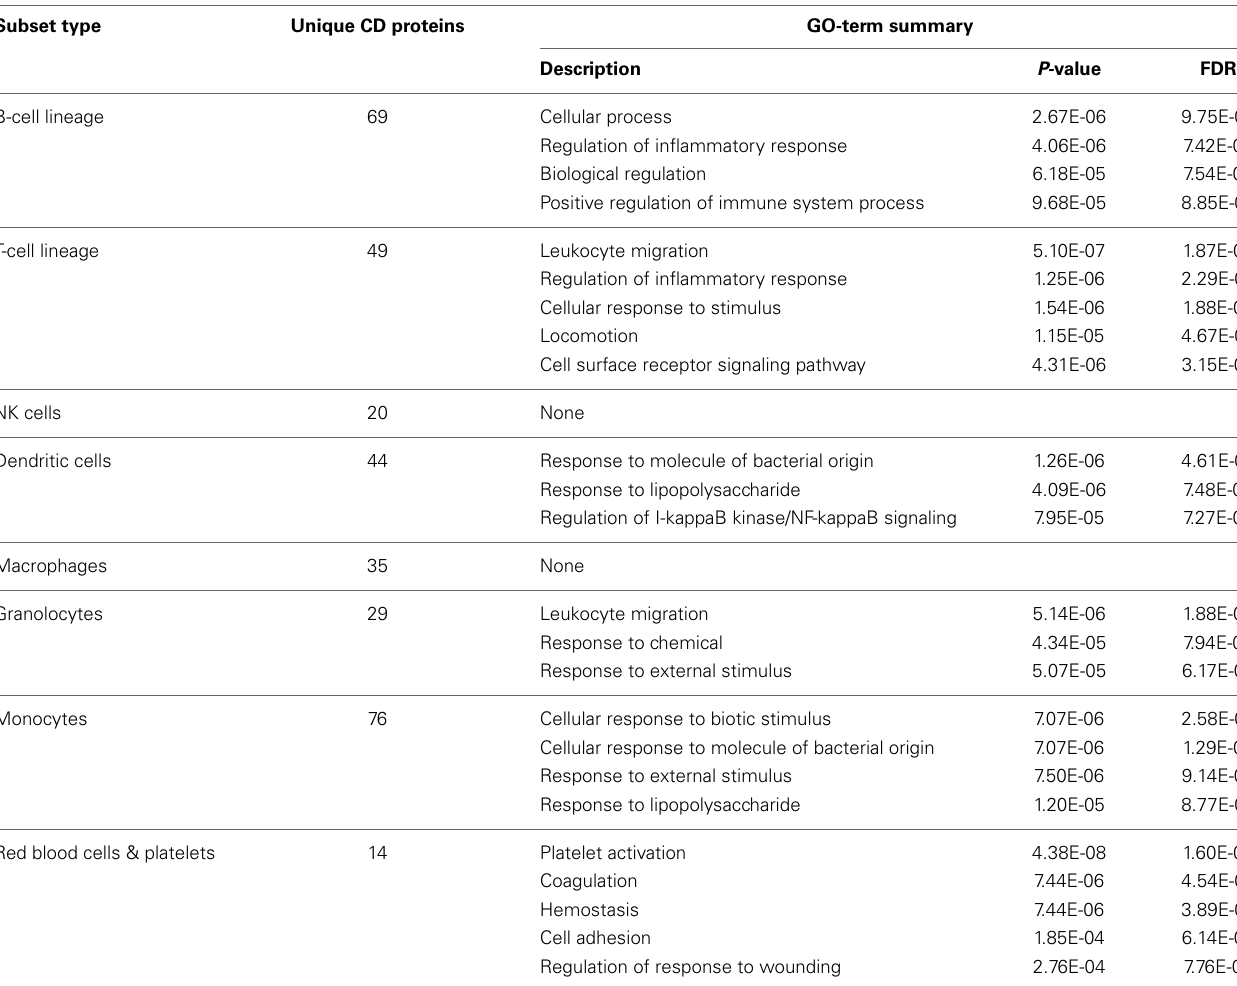
Table 3 | Enriched GO term’s based on the expression patterns of CD proteins can be used to differentiate cellular subtypes within the hematopoietic